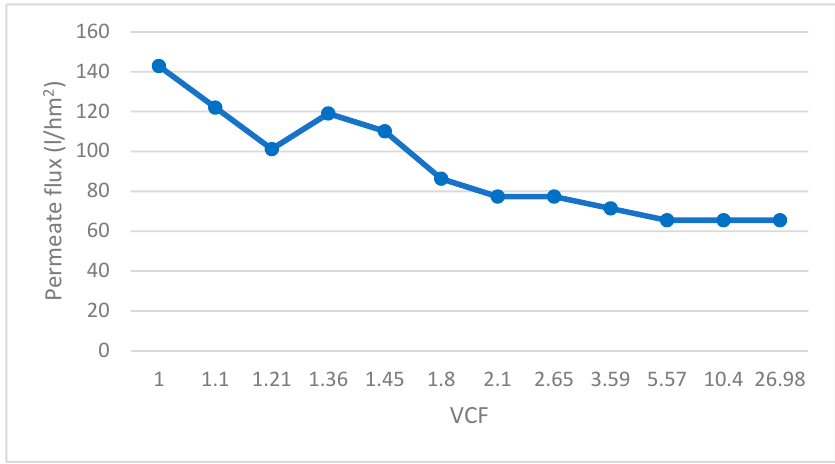
Figure 5. Permeate flux vs. VCF over the duration of the ultrafiltration pilot test.